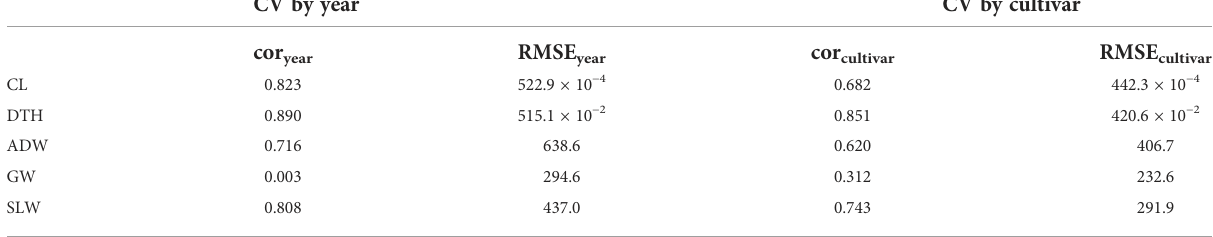
TABLE 3 Prediction accuracy of fi ve traits evaluated by CV by year and by cultivar.